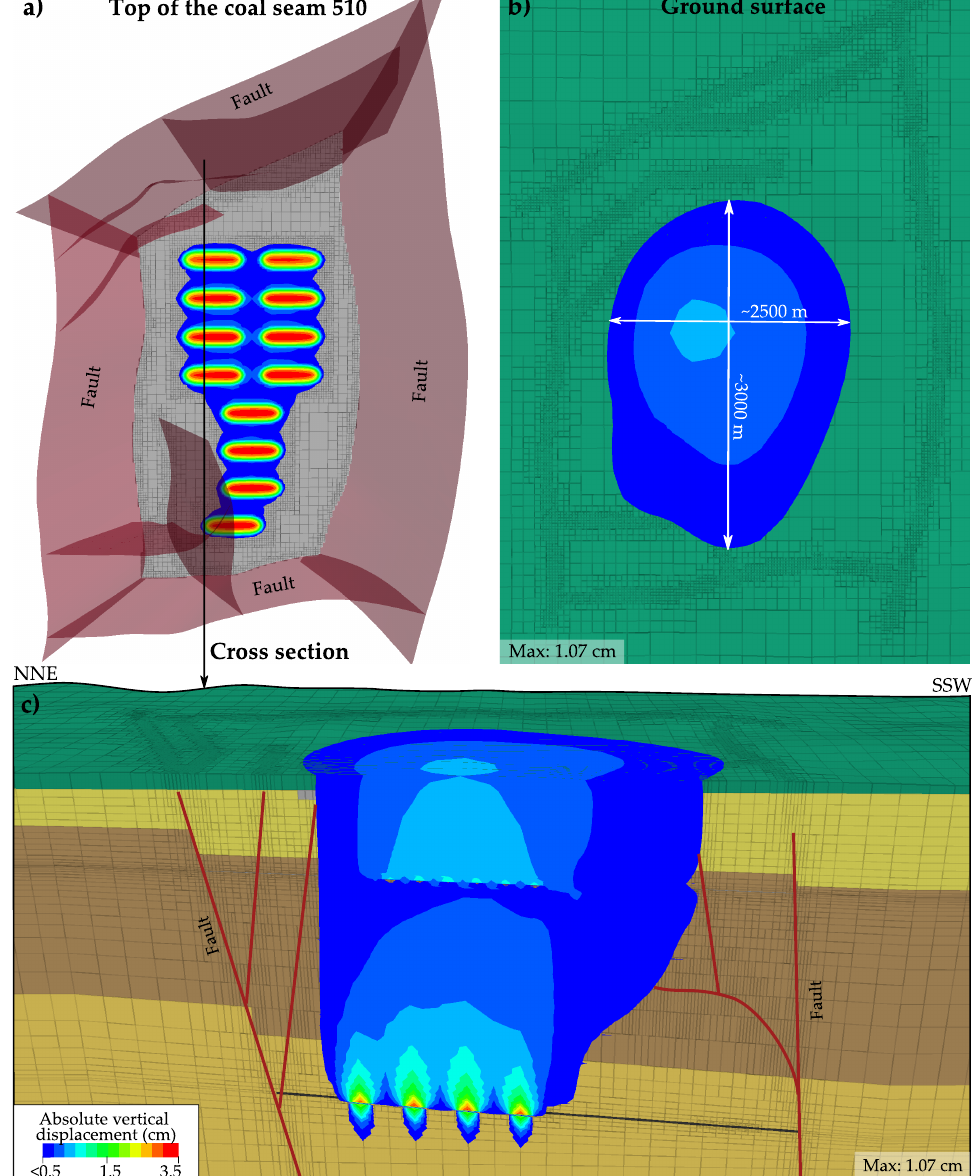
Figure 9. Simulated vertical displacements in ( a ) map view above coal seam 510, ( b ) at the ground surface and ( c ) along a NNE-SSW trending cross section as for an injection in both coal seams with the respective maximum injection pressures for the operational state (1